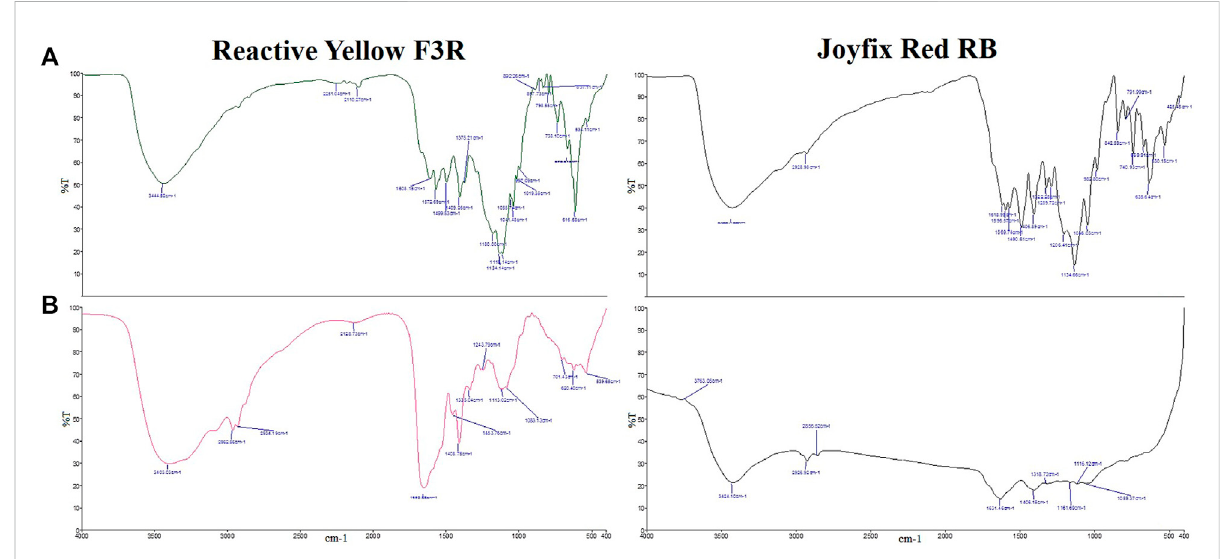
FIGURE 3 FTIR spectra of (A) Reactive Yellow F3R, Joy fi x Red RB control dyes and (B) degradation products by L. sphaericus MTCC